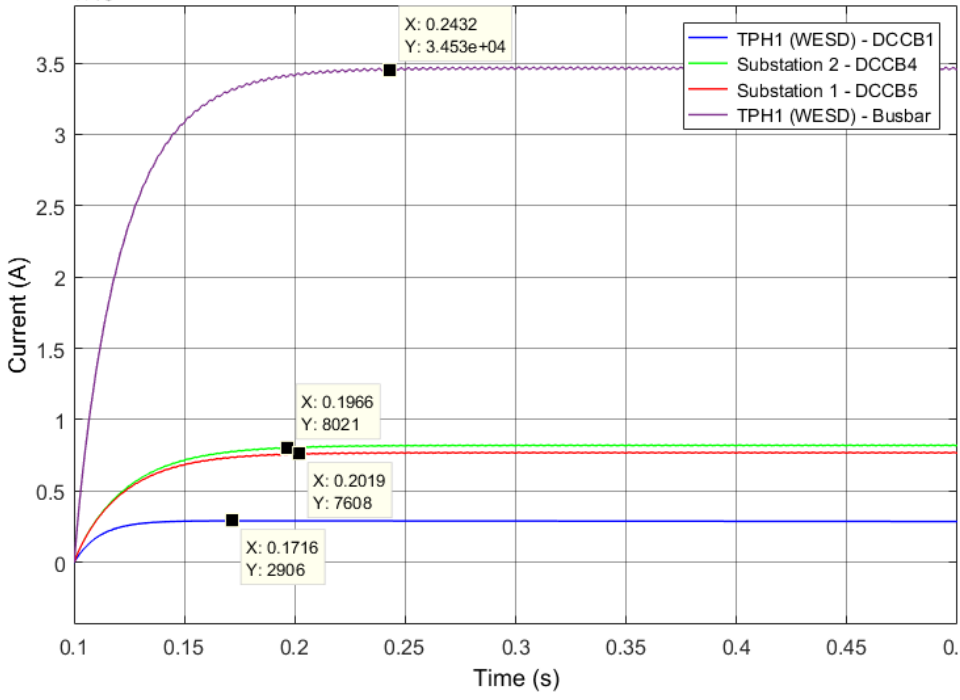
Figure 14. Simulation results of Scenario F2. Fault current (A) vs. time (s) observed with DCCB1 (TPH 1—blue), DCCB4 (Substation 2—green), DCCB5 (Substation 1—red), and TPH1 busbar (violet). Figure 15 shows that the WESD feeds approximately 3 kA to the fault. The state of charge (SOC) of the WESD SC cells drops at 0.4 s from 100% to below